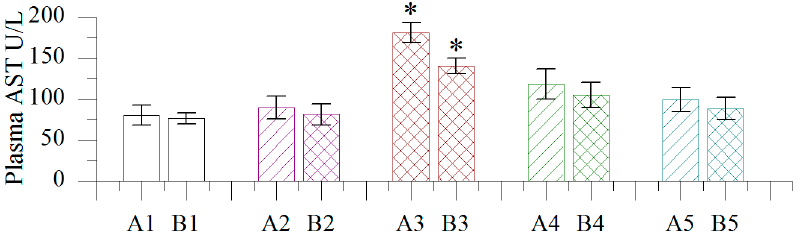
Figure 2. Effect of different concentrations of volatile oil from Blumea balsamifera (BB oil) on plasma AST levels in rats. 1–5: CK, Olive oil, 100% BB oil, 50% BB oil, 20% BB oil; A, B: normal skin, wound skin; *: Columns labeled by * are significantly different from others by Duncan’s test at p <